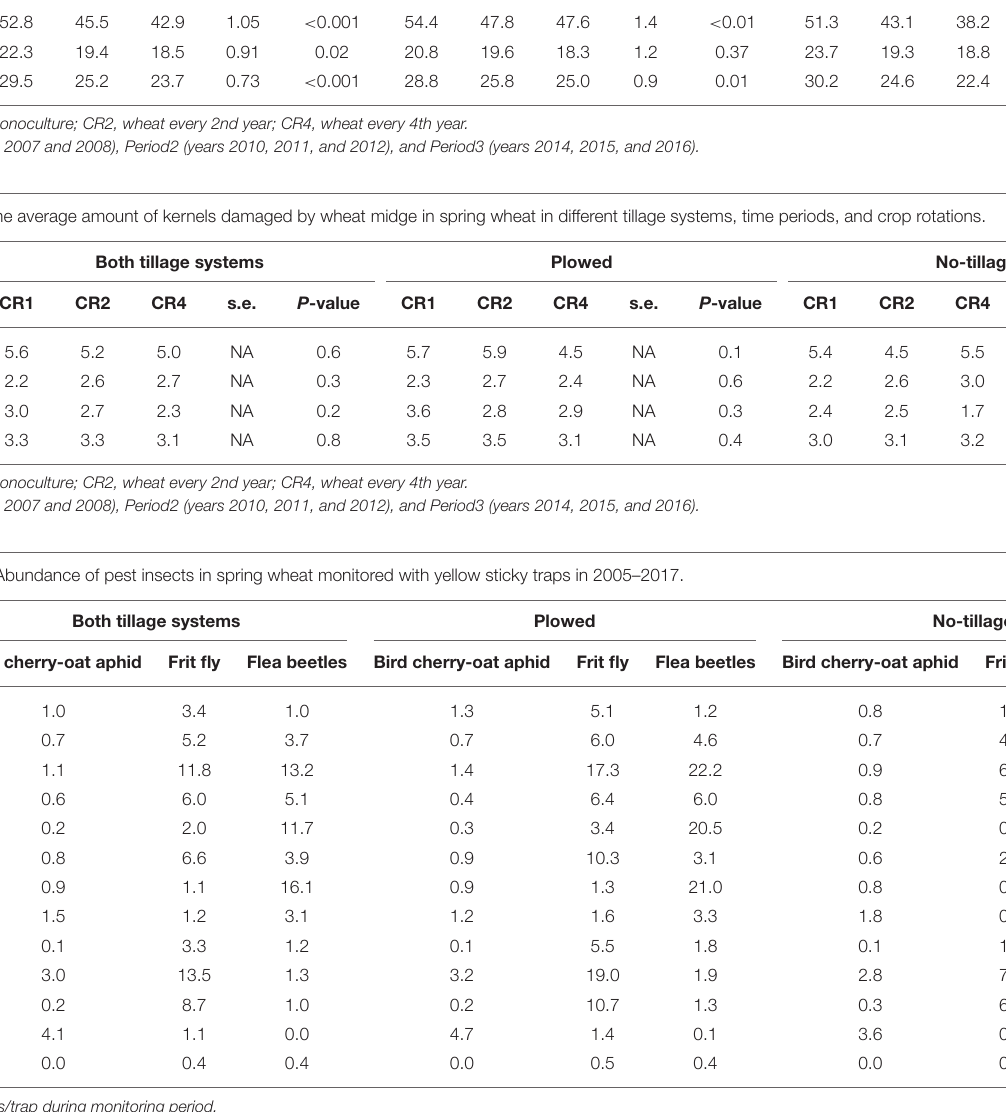
TABLE 8 | The average leaf blotch disease severity (%) in spring wheat in different tillage systems, time periods, and crop rotations. Both tillage systems Plowed No-tillage CR1 CR2 CR4 s.e. P -value CR1 CR2 CR4 s.e. P -value CR1 CR2 CR4 s.e. P -value Period1 Period2 Period3